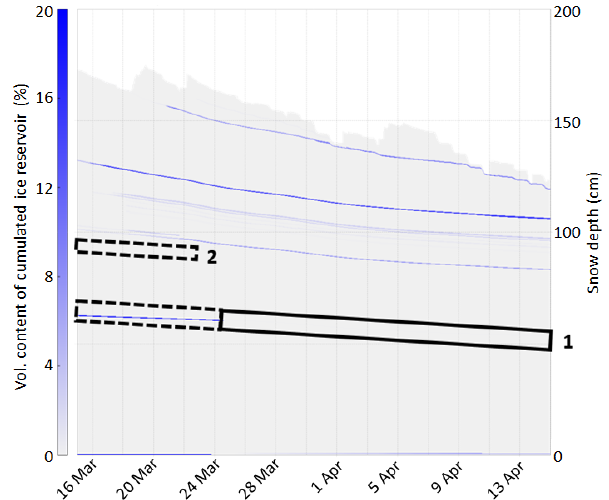
Figure 14. SNOWPACK simulation RE/PF/IceR from 15 March to 15 April 2017 at WFJ: volumetric ice content in the cumulated ice reservoir. Rectangles highlight layers 1 and 2 with dashed lines be- fore ice formation in the matrix domain and solid lines